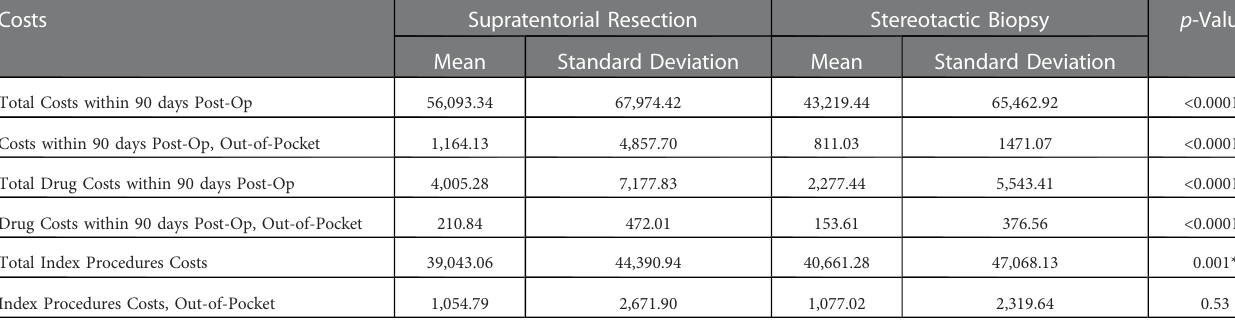
TABLE 4 Costs associated with resection and stereotactic biopsy in overall cohort (United States dollars).